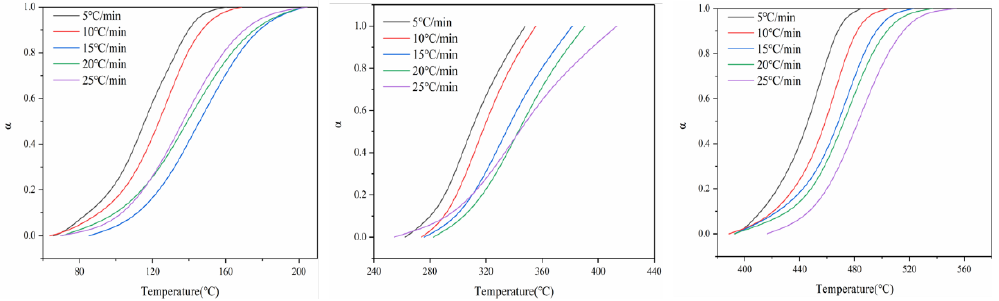
Figure 3. Conversion curves of three stages of battery material pyrolysis.